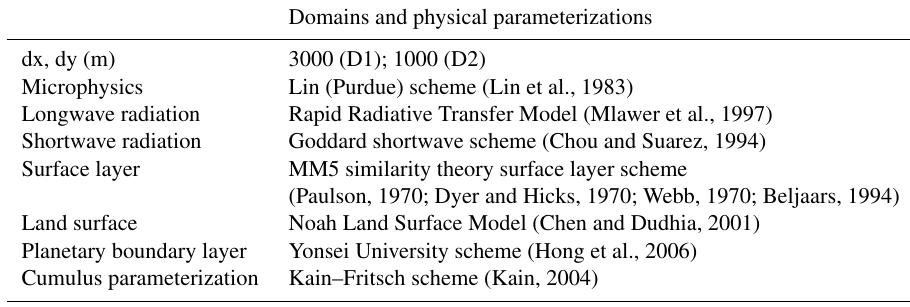
Table 2. Configuration of the WRF model domains and physical parameterizations.